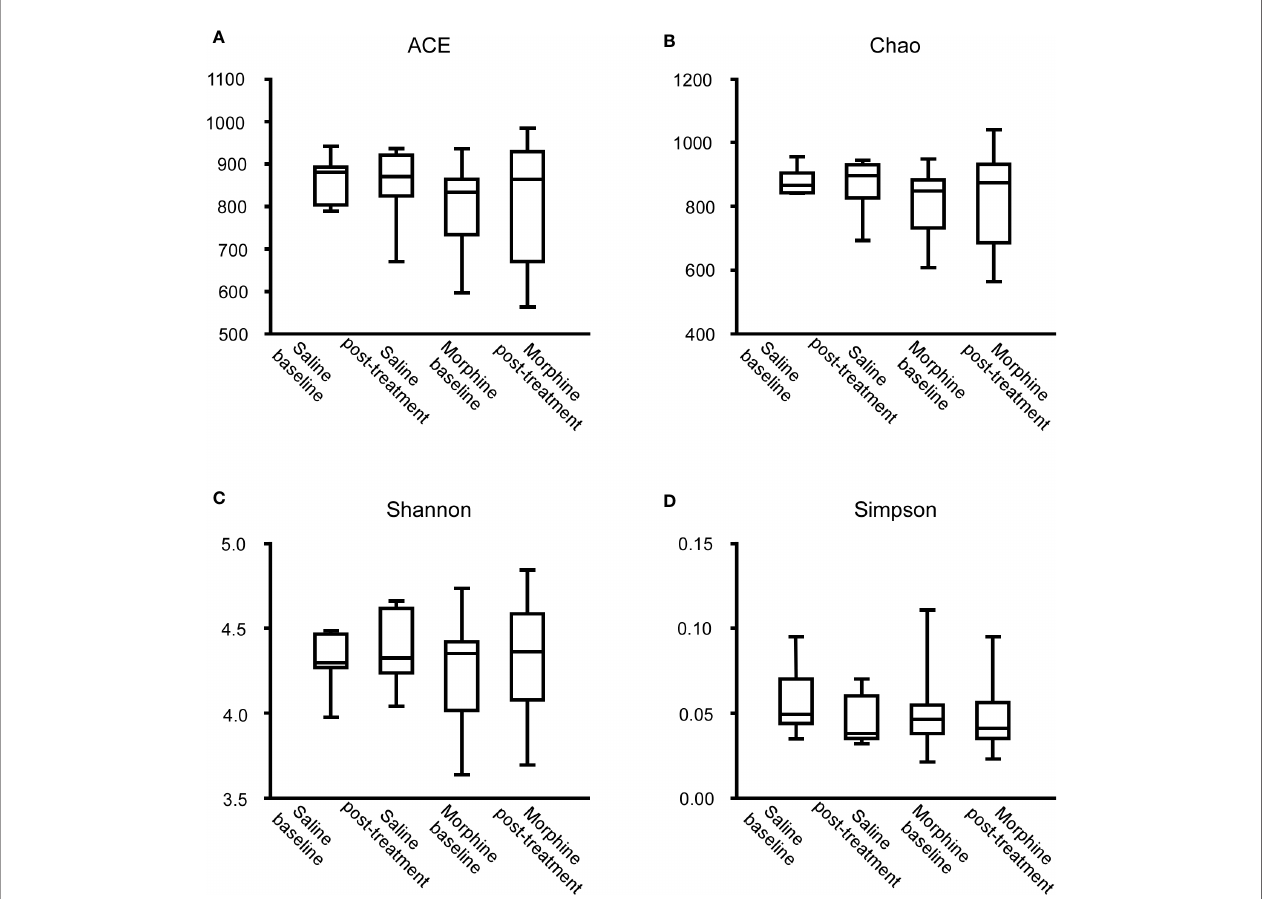
FIGURE 3 | Comparison of the community alpha diversity. Alpha diversity was measured by ACE (A) , Chao (B) , Shannon (C) and Simpson (D) . A Mann-Whitney test or student ’ s t test was used to analyze the data. The central line shown in each box plot indicates the median of data. Whiskers extend to cover the whole range of values. Statistical signi fi cance was accepted at p < 0.05. *p < 0.05; **p < 0.01; ***p < 0.001; ****p <